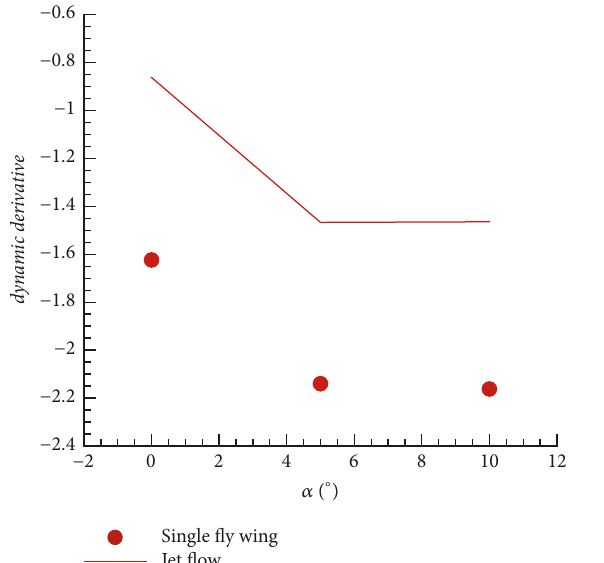
Figure 16: Dynamic derivatives 𝐶 𝑚 ̇𝛼 + 𝐶 𝑚𝑞 .